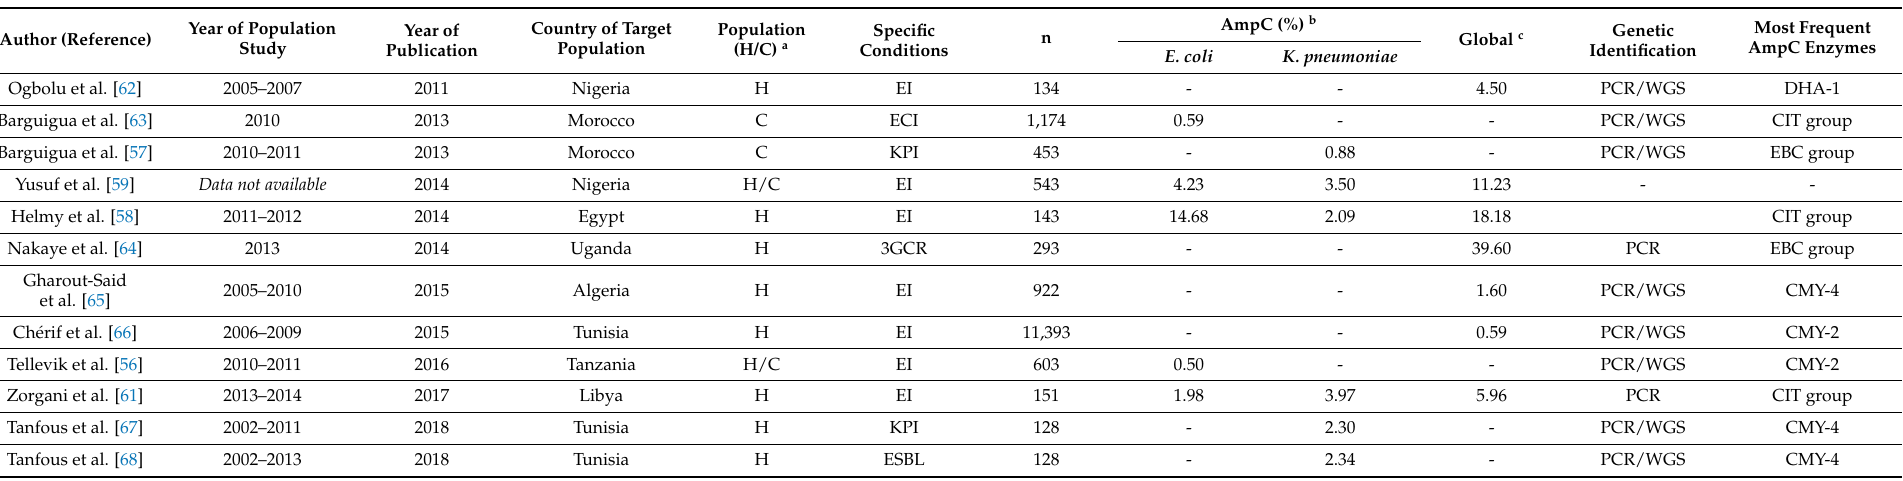
Table 4. Epidemiology of pAmpC-BLs in Africa